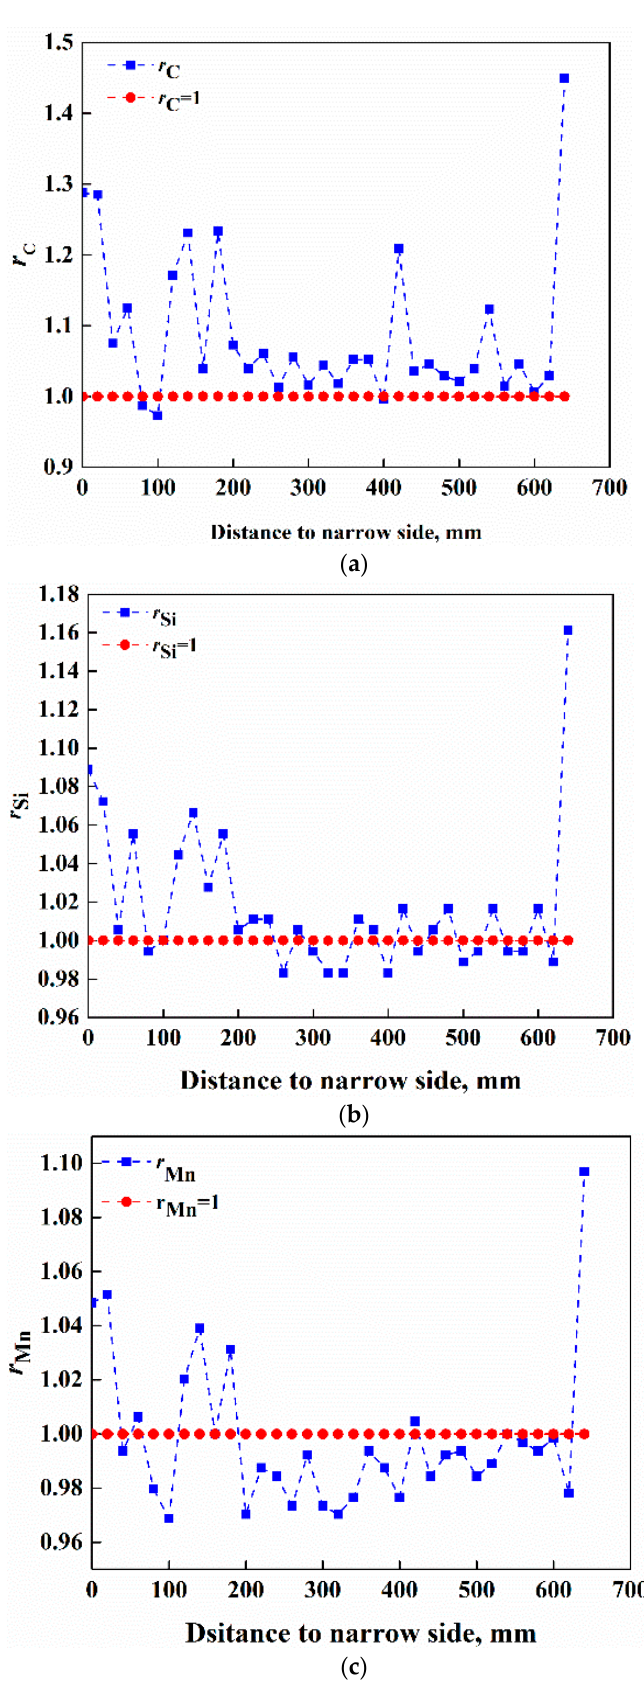
Figure 8. Centerline segregation degree ( a ) r C, ( b ) r Si , and ( c ) r Mn .